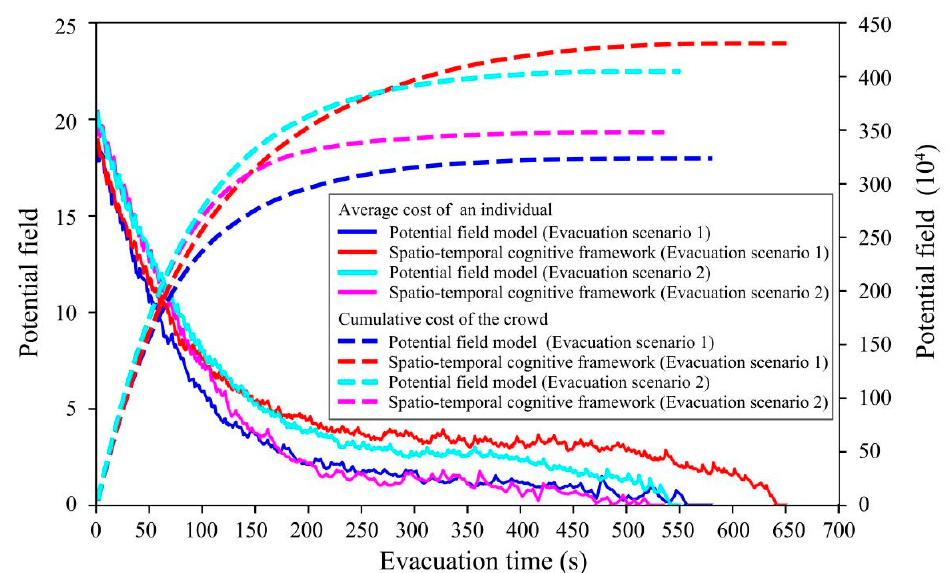
Figure 11. The cumulative count of the crowd not evacuated and the proportion of the crowd not evacuated in different evacuation scenarios.